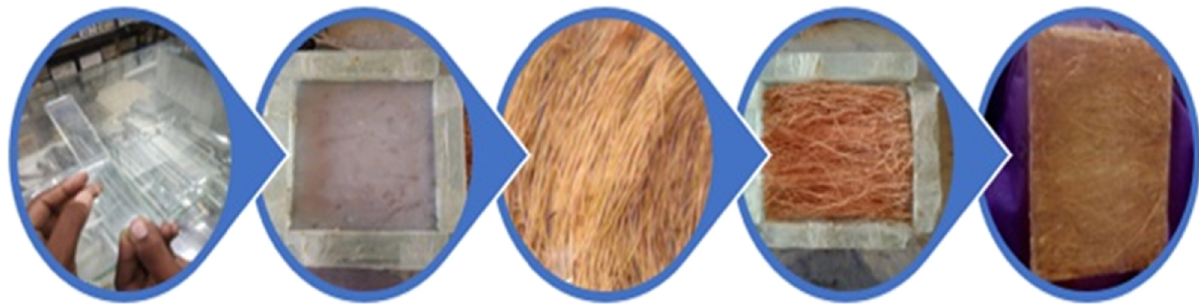
Figure 1: Processing of